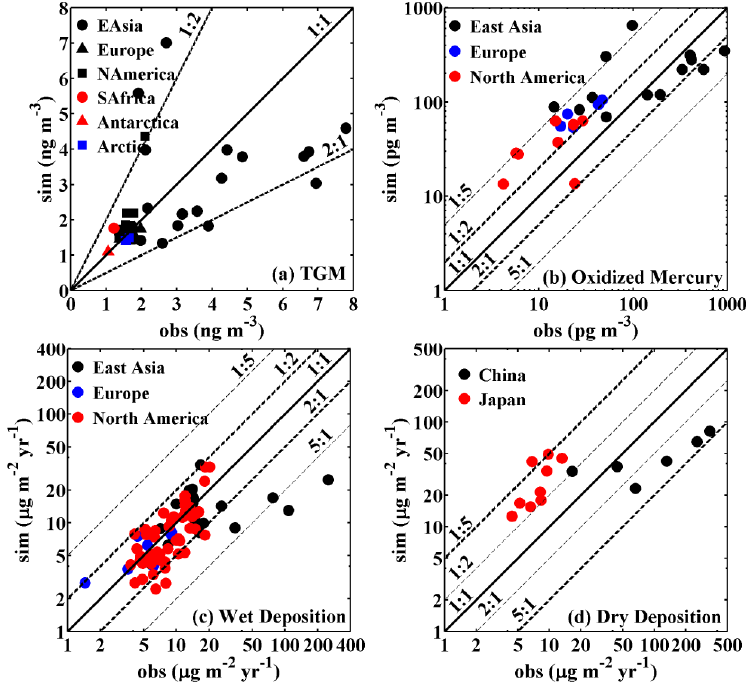
Figure 10. Simulated vs. observed (a) TGM (ngm − 3 ), (b) oxidized mercury (pgm − 3 ), (c) wet deposition (µgm − 2 yr − 1 ), (d) dry deposition (µgm − 2 yr − 1 ) in different regions. Note that coordinates are different in different